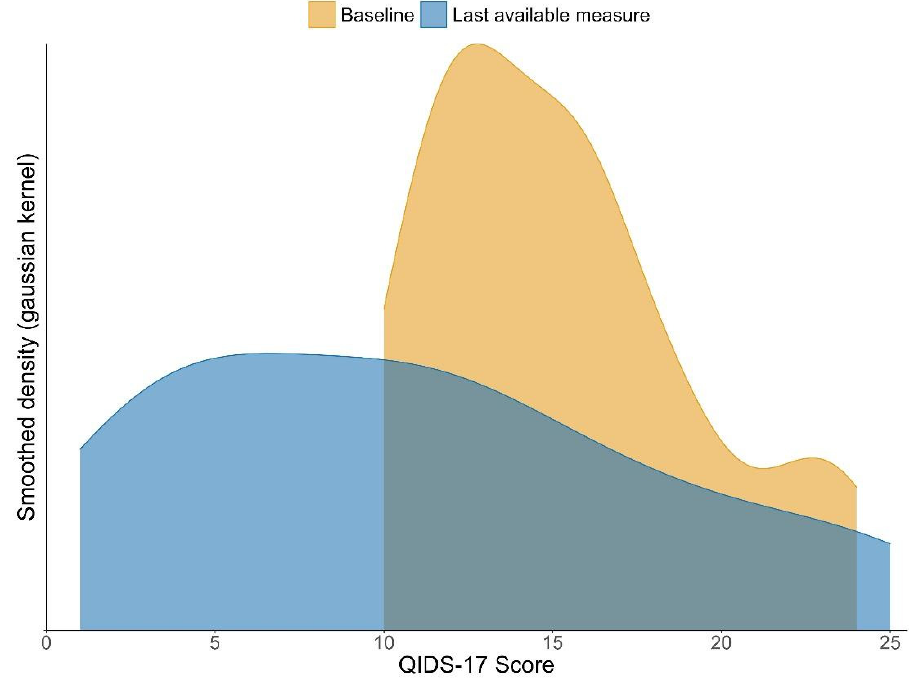
Figure 3. Densities of baseline and end of treatment QIDS-A17-SR ratings. Notes: This graph shows smoothed and trimmed densities estimated from the QIDS-A17-SR distributions at baseline and at the last available measurement (end of treatment or before, if end of treatment measure was not available).